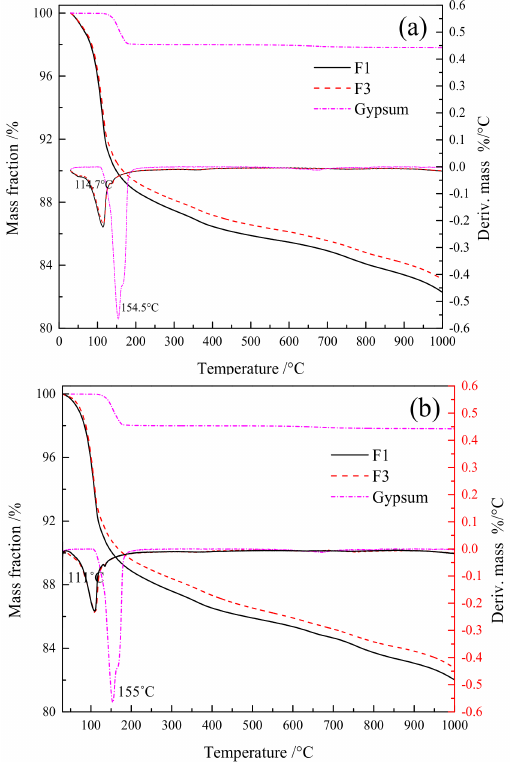
Figure 4. TG/DTG curve of F1 and F3 groups at 7 d and 28 d: ( a ) 7 d, ( b ) 28 d.